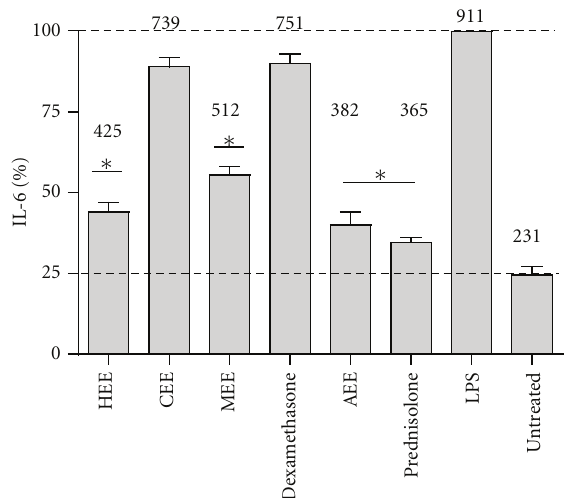
Figure 4: Anti-inflammatory activity of extracts and fractions from Laennecia confusa . An inflammatory process was elicited by exposing macrophages to LPS. Crude extracts were exposed to macrophages before the addition of LPS. The anti-inflammatory process was evaluated by measuring the secretion of IL-6 into the supernatant. Shown is the mean ± SD of three independent ex- periments. Numbers on the bars indicate the concentration of IL- 6 in pg/mL. HEE, CEE, MEE, and AEE are hexane, chloroform, methanol, and aqueous extracts, respectively. ∗ P value <